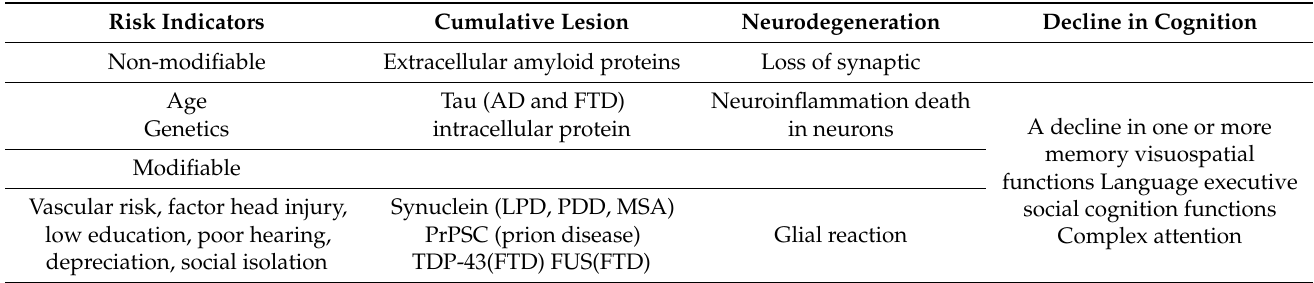
Table 1. Primary dementias as a clinical entity